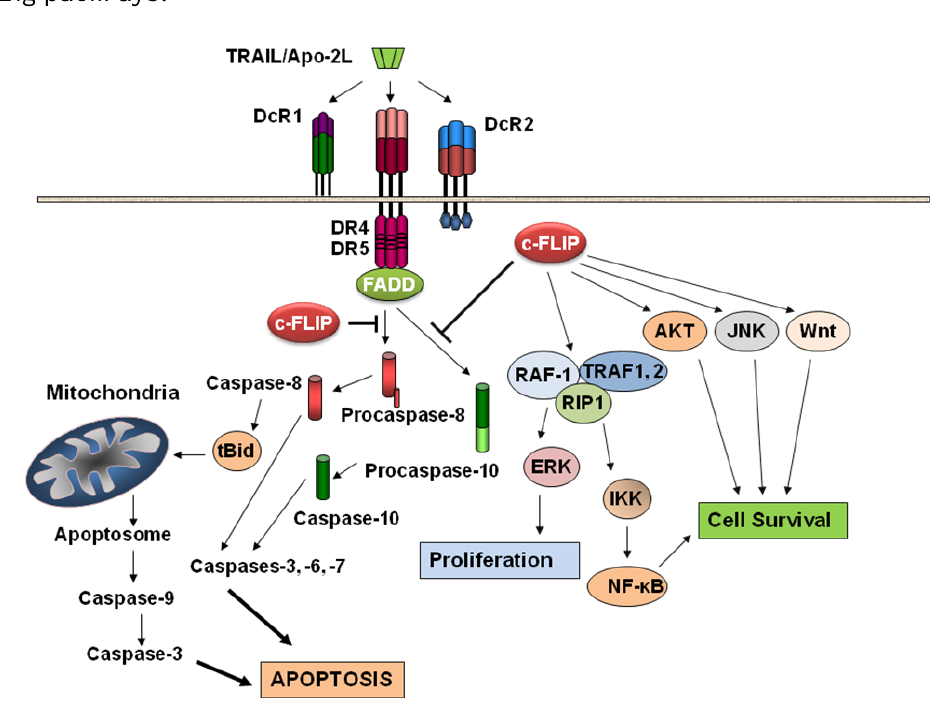
Figure 1. Schematic overview of the multifunctional roles of c-FLIP in the TRAIL- triggered apoptosis pathway as well as activating various anti-apoptotic and cell survival signaling